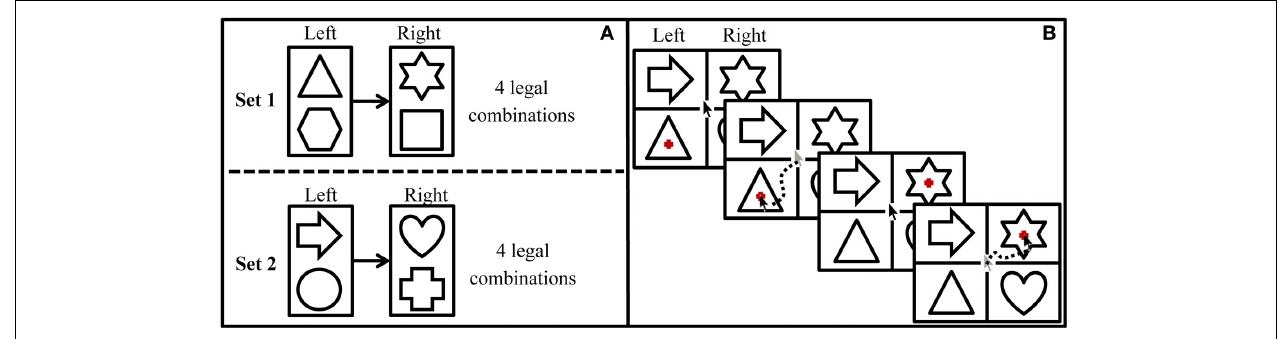
FIGURE 2 | Structure of the statistical learning task. (A) Structure of the grammar in which the first target is always displayed on the left side of the screen and the second target is always displayed on the right side of the screen. (B) Procedure of a grammatical trial during the exposure